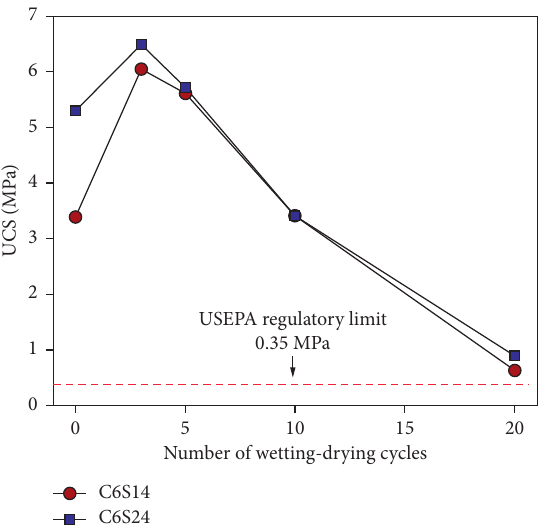
Figure 8: Evolutions of the UCS with wetting-drying cycles of the stabilized Cr-contaminated soils.